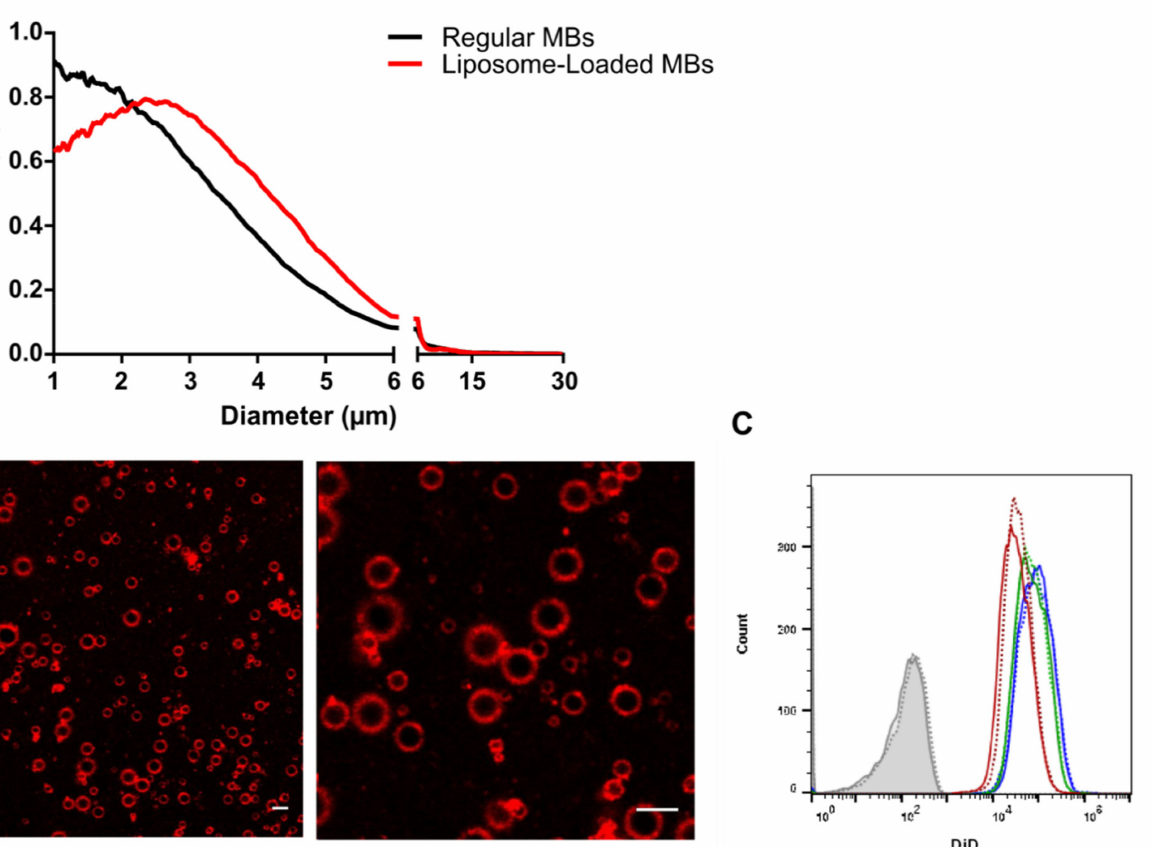
Figure 1. Characterization of liposome-loaded microbubbles. ( A ) Size distribution of biotinylated lipid microbubbles with (red line) and without (black line) liposomes attached, displayed in number% of the total microbubble population. ( B ) Confocal images of fluorescently labelled liposome-loaded microbubbles. Red fluorescence indicates the presence of DiD labelled liposomes. Scale bar equals 5 µ m ( C ) Flow cytometry histograms of liposome-loaded microbubbles diluted in HEPES (full line) or full serum (dotted line). Coloured histograms (green, blue, red) represent different batches of liposome-loaded microbubbles. Grey histograms represent unloaded microbubbles as a